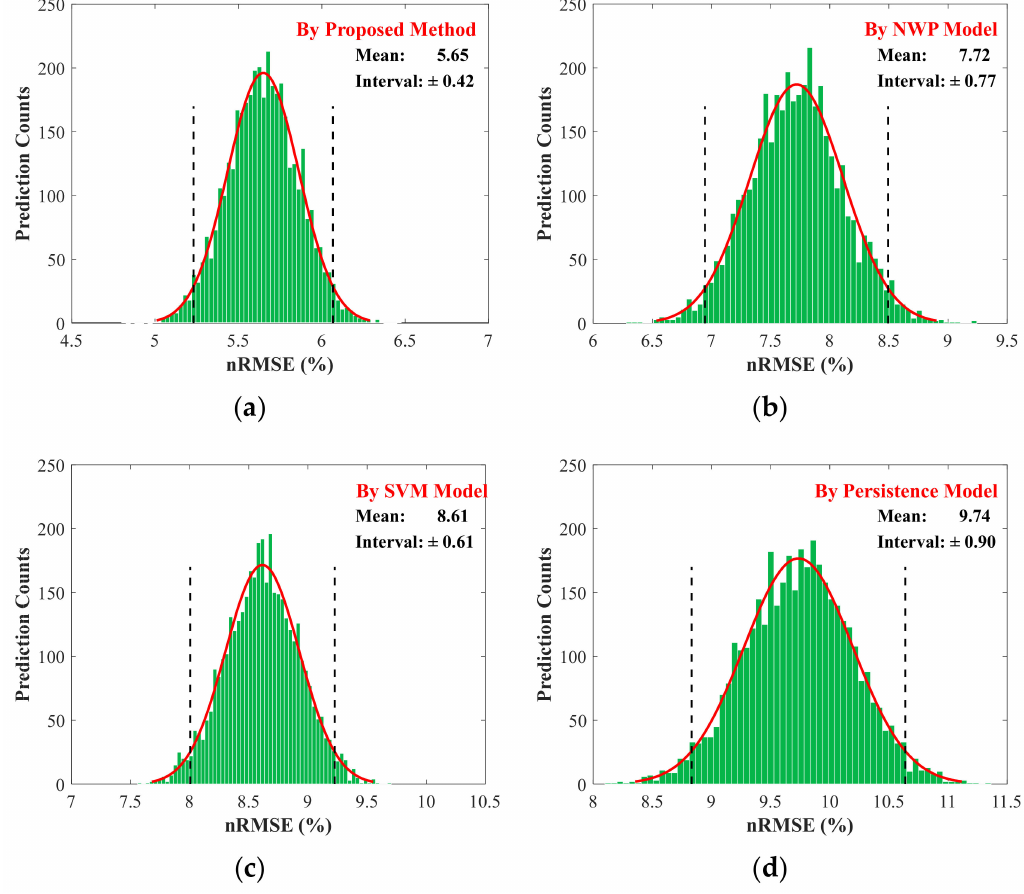
Figure 14. Histogram comparison of the forecast nRMSE: ( a ) using the proposed method; ( b ) using the NWP model; ( c ) using the SVM model; ( d ) using the persistence